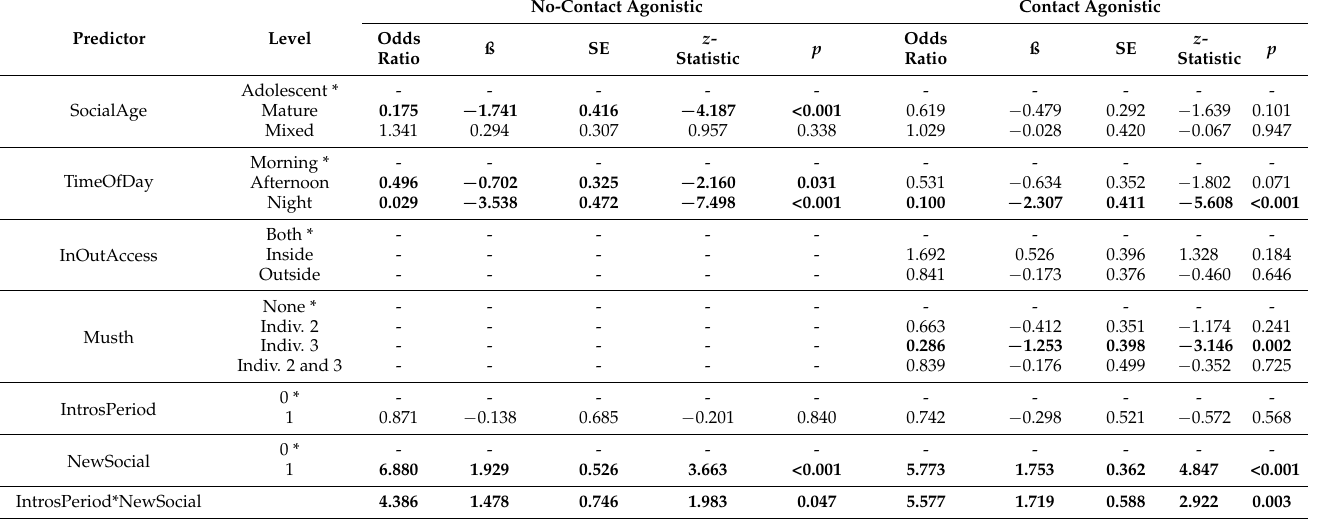
Table A5. Adolescent GLMER model parameter estimates for agonistic response variables. General- ized linear mixed-effect model results of associations between predictor variables (fixed effects) and behavioral response variables for adolescent focal animals. ß = Beta coefficients from model outputs: positive values indicate an increase in odds compared to the reference level while negative values indicate a decrease in odds compared to reference level; SE = standard error of beta coefficients; Wald X 2 = Chi-squared statistic from Wald test with df = 1; p = p -value from Wald test. * indicates reference level. Bold signifies statistical significance ( p < 0.05).